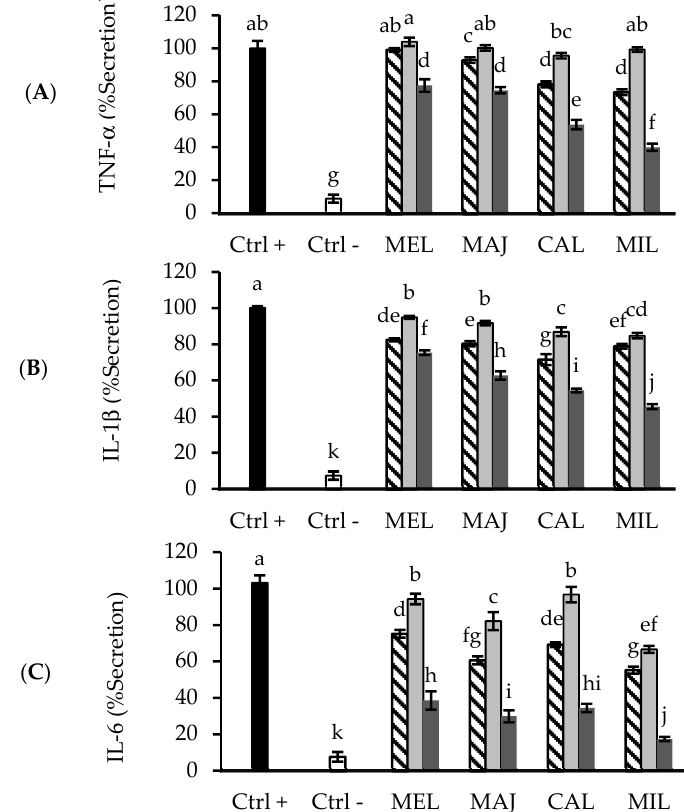
Figure 1. Levels of ( A ) TNF- α , ( B ) IL-1 β and ( C ) IL-6 secreted by THP-1 macrophages, activated with LPS, in presence of 10 μ g/mL of SFE (stripped bars), UAE-50 (light grey bars) and UAE-100 (dark grey bars) plant extracts. Ctrl+, positive control (cells stimulated with LPS without extract). Ctrl − , negative control (cells non-stimulated). MEL, Melissa officinalis L., MAJ, Origanum majorana L., CAL, Calendula officinalis L, MIL, Achillea millefolium L. Each bar is the mean of three determinations ± SD. a–k Different letters indicate statistical differences among LSD procedure ( p <